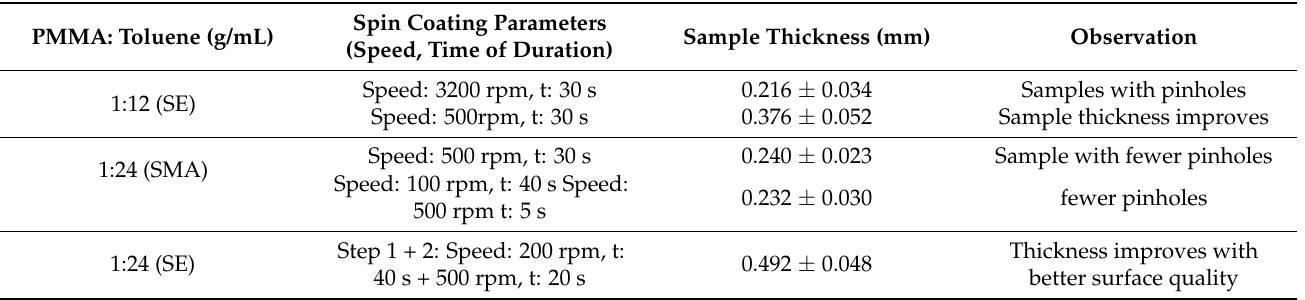
Figure 2. Spin coating deposition of PMMA on NiTi strip. Table 1. Parameters for uniform coating of PMMA on NiTi surface by spin coating method and corresponding